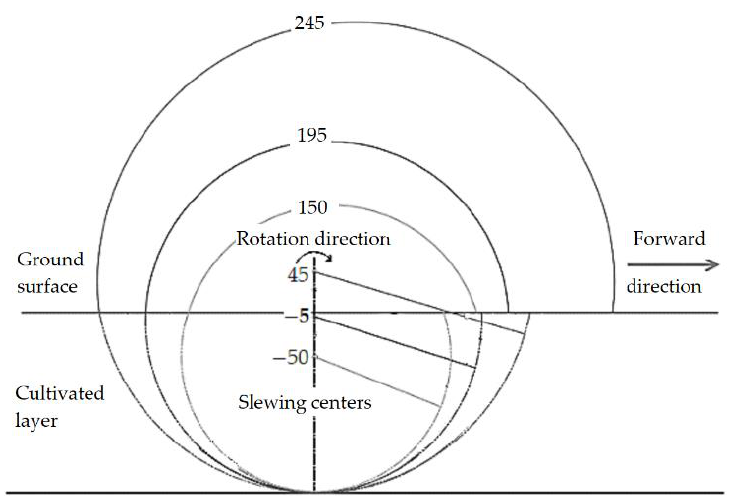
Figure 6. Initial position of the rotary blade.